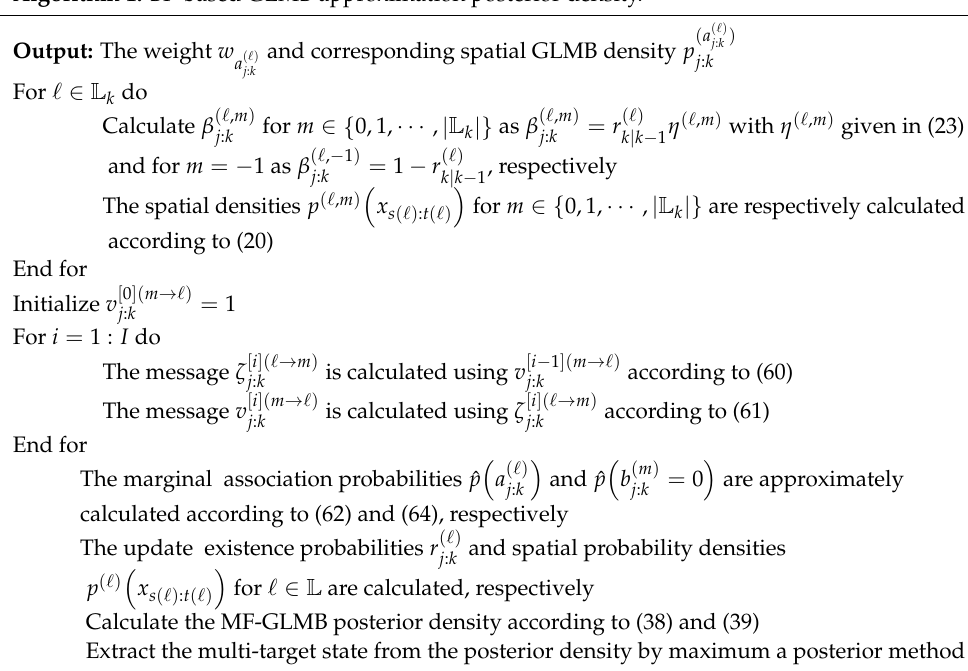
Algorithm 1: BP-based GLMB approximation posterior